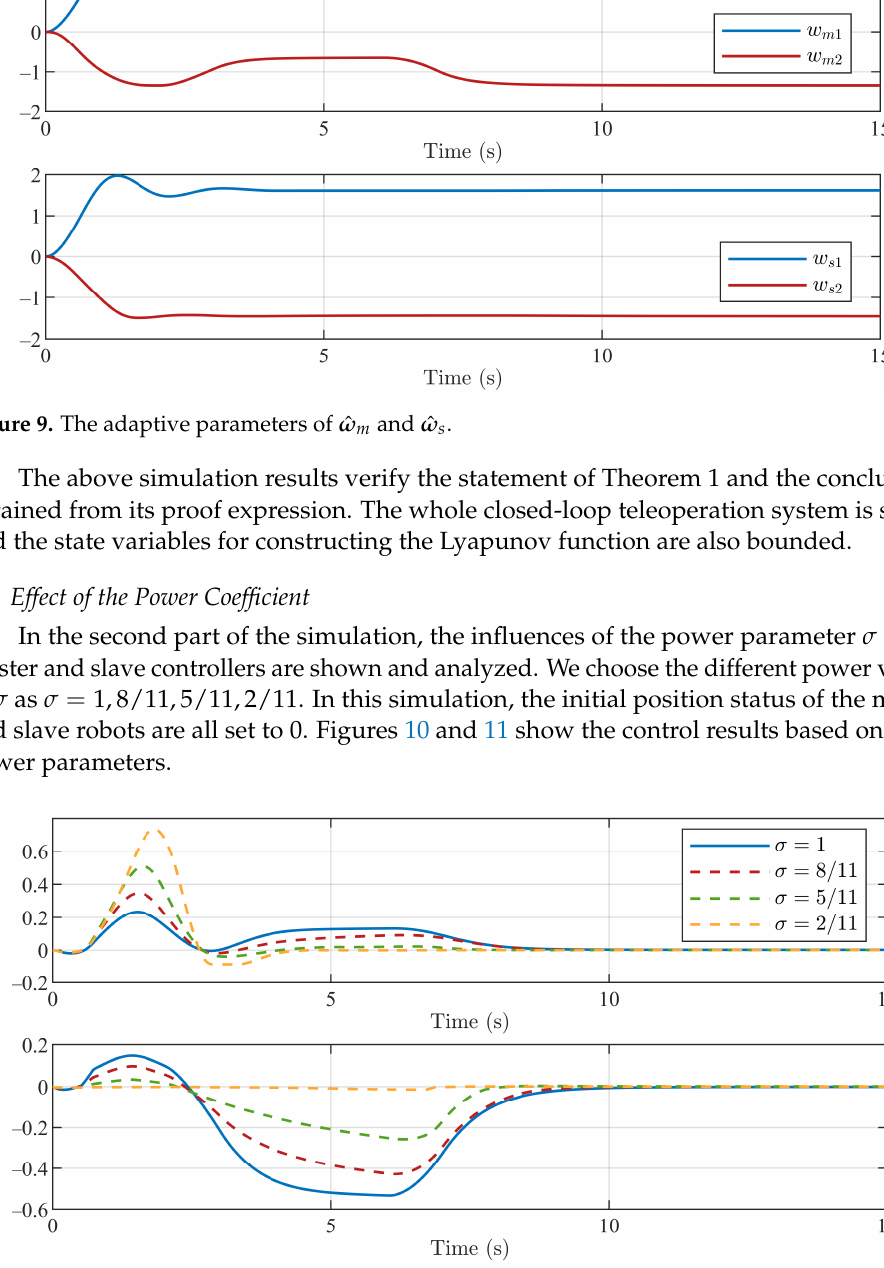
Figure 10. Position tracking errors between the master and the salve with different values of σ